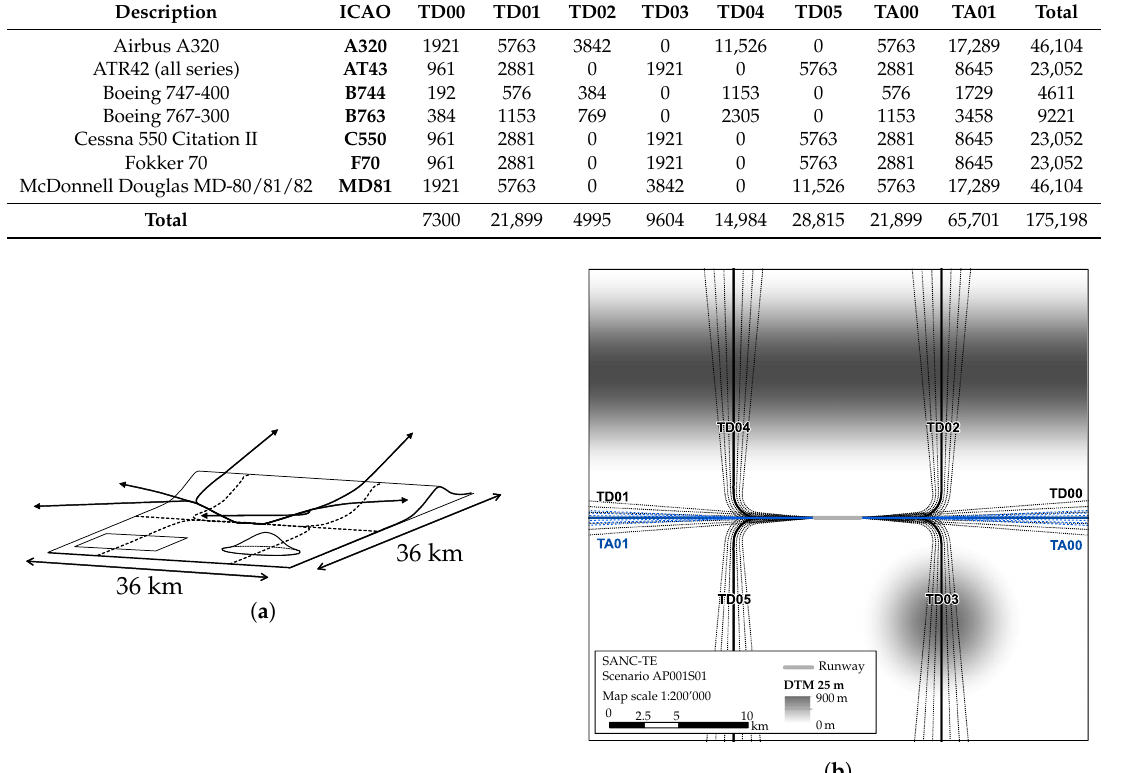
Table 1. Swiss Aircraft Noise Calculation Test Environment (SANC-TE) aircraft types and number of yearly movements of the SANC-TE scenario AP001S01. The aircraft type A320 was substituted by the three aircraft concepts V-R, “retrofit” and “gamechanger”.